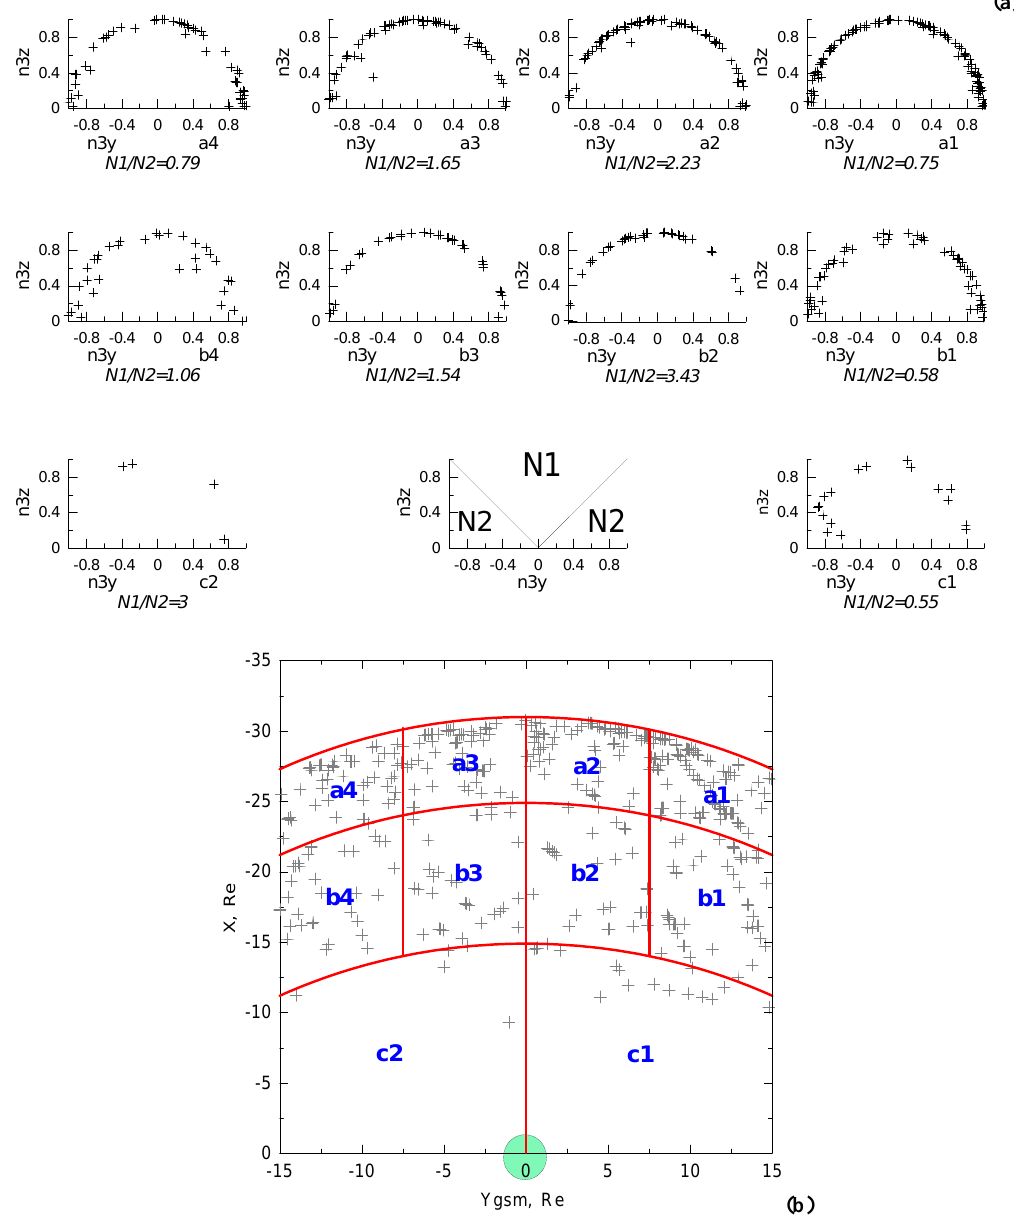
Fig. 7. Distribution of the MVA normals in the YZ plane in the current-sheet related coordinate system. Data are shown separately in different R-Y bins (a) according to the scheme shown in part (b) . The ratio of crossings with the normals within the ± 45 ◦ cone around the nominal CS sheet normal (N1) and of remaining crossings (N2) is shown to characterise quantitatively the spread of the normals around the n =1